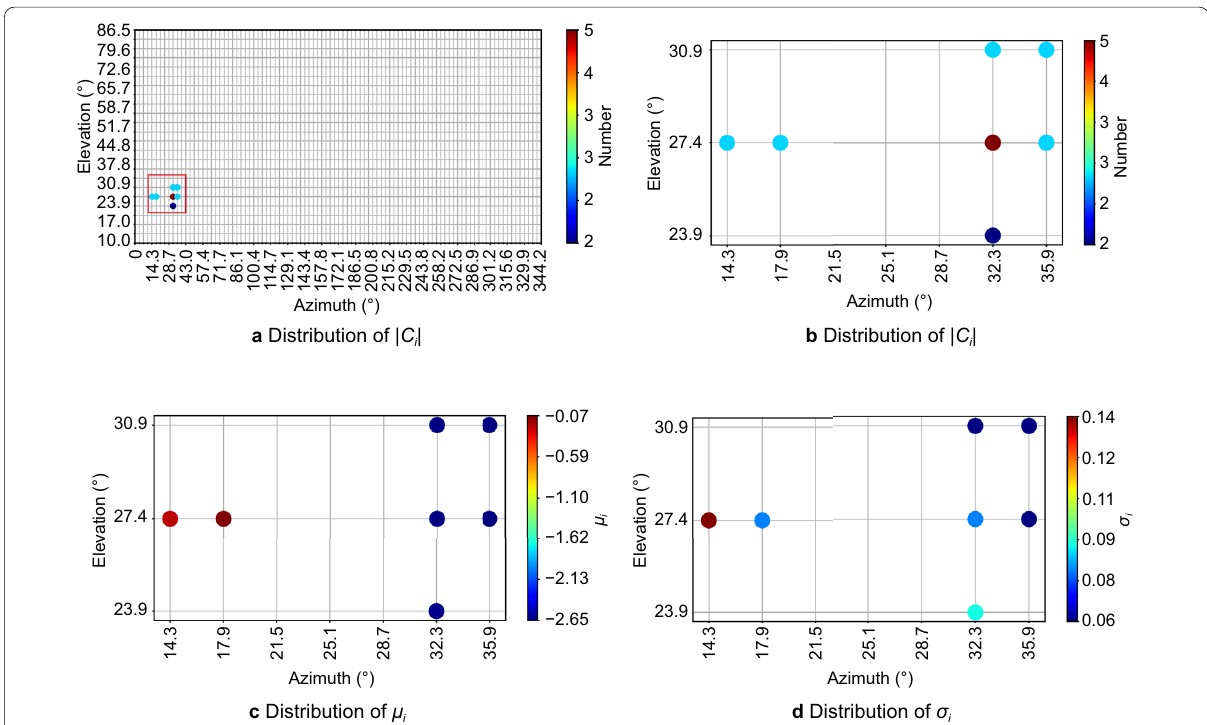
Fig. 8 Distribution of | C i | (the top two sub‑plots), μ i (the left‑bottom sub‑plot), σ i (the right‑bottom sub‑plot) in Eq. (7) against elevation angle and azimuth angle for latitude 71.3° and longitude 32.4° of solution D ( 48 × 32 × 24 × 100 ) on DOY 001, 2020